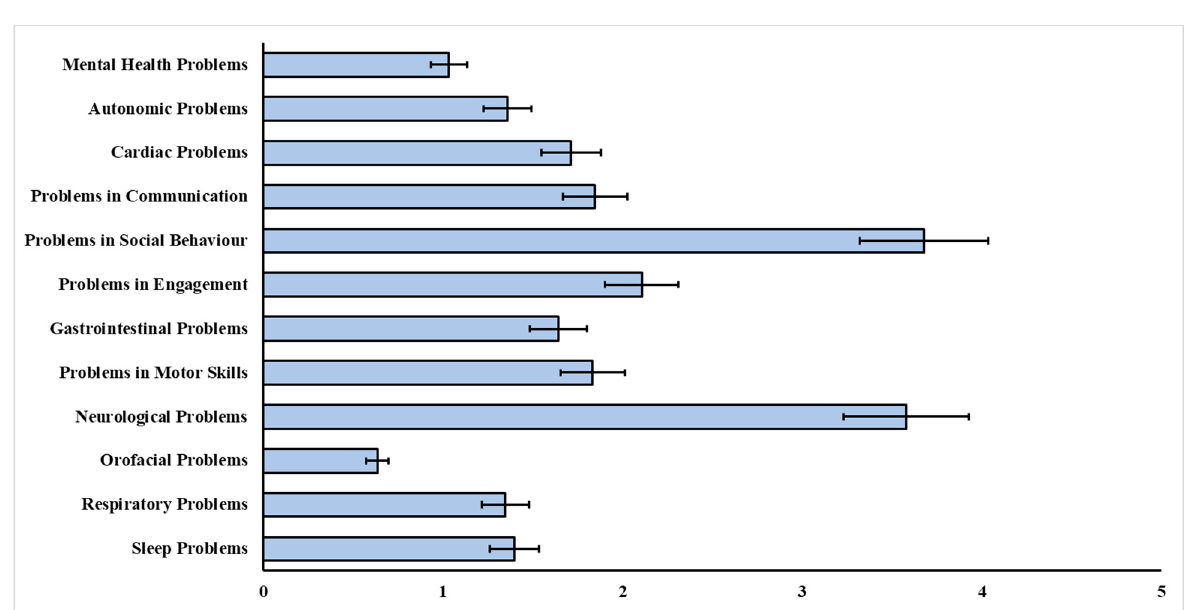
Figure 3. Mean sub-scale scores of the MPSS in Rett syndrome ( n = 106). Notes: error bars are presented as the standard error .